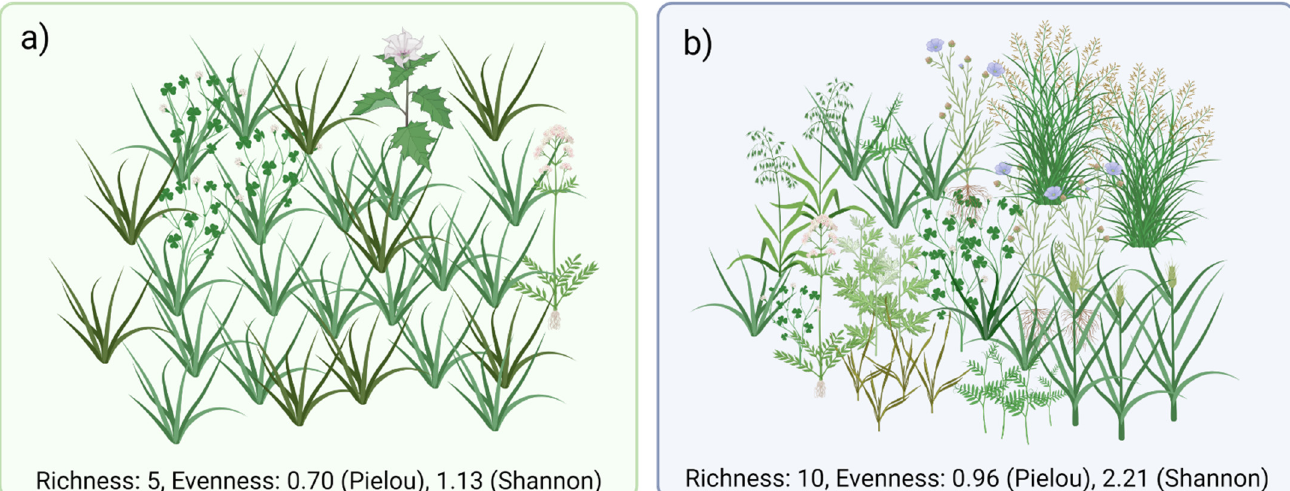
Figure 1. Illustrated hypothetical example of differences in diversity following the random sampling of 30 individuals from relatively low ( a ) and high ( b ) diversity pastures. The high diversity pasture ( b ) has more species (richness), a more even distribution of species (evenness), and species with a wider variety of phenotypic characteristics (disparity). Diversity indices are Shannon’s H and Pielou’s E. Created with BioRender.